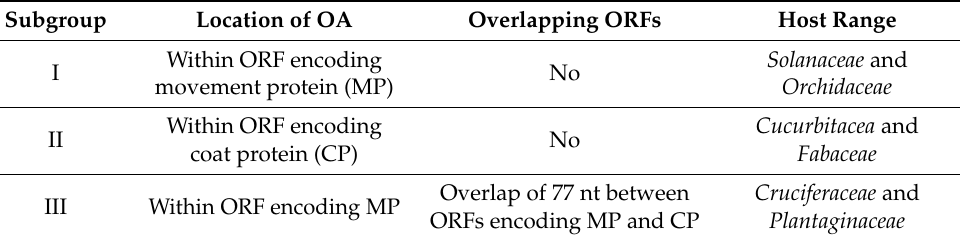
Table 1. Division of tobamoviruses into subgroups based on genome organization and host range. Subgroup Location of